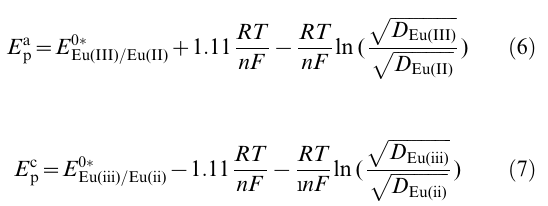
ffiffiffiffiffiffiffiffiffiffiffiffiffiffiffi D p Eu(III) p ) ð 6 Þ ffiffiffiffiffiffiffiffiffiffiffiffiffi D Eu(II) ffiffiffiffiffiffiffiffiffiffiffiffiffiffi D p Eu(iii) p ) ð 7 Þ ffiffiffiffiffiffiffiffiffiffiffiffiffi D Eu(ii)